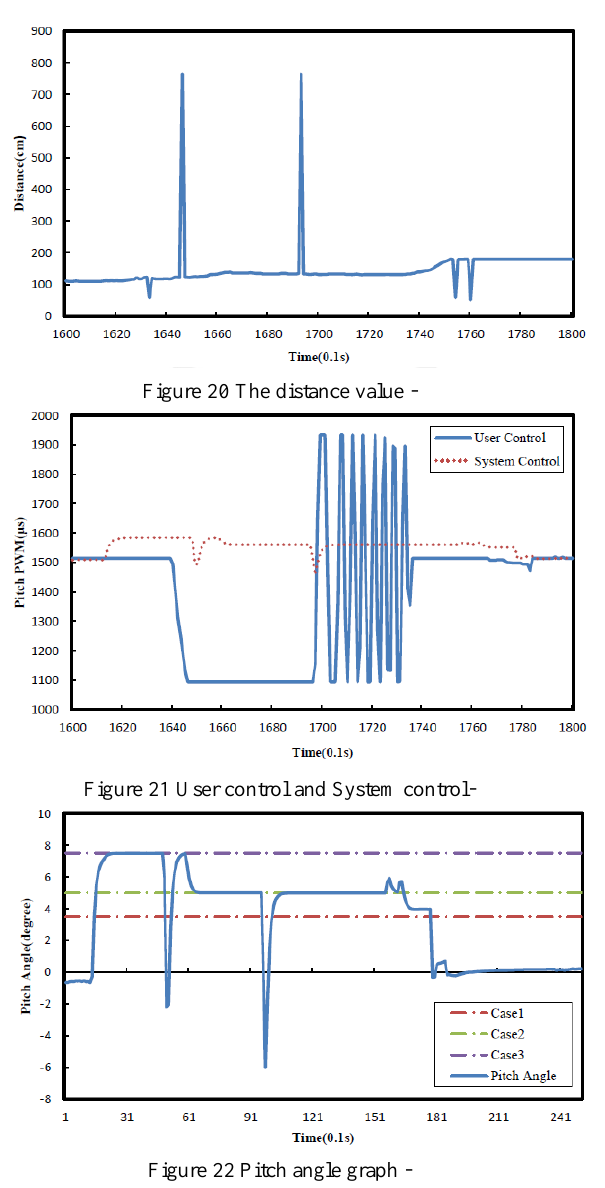
Figure 22 Pitch angle graph